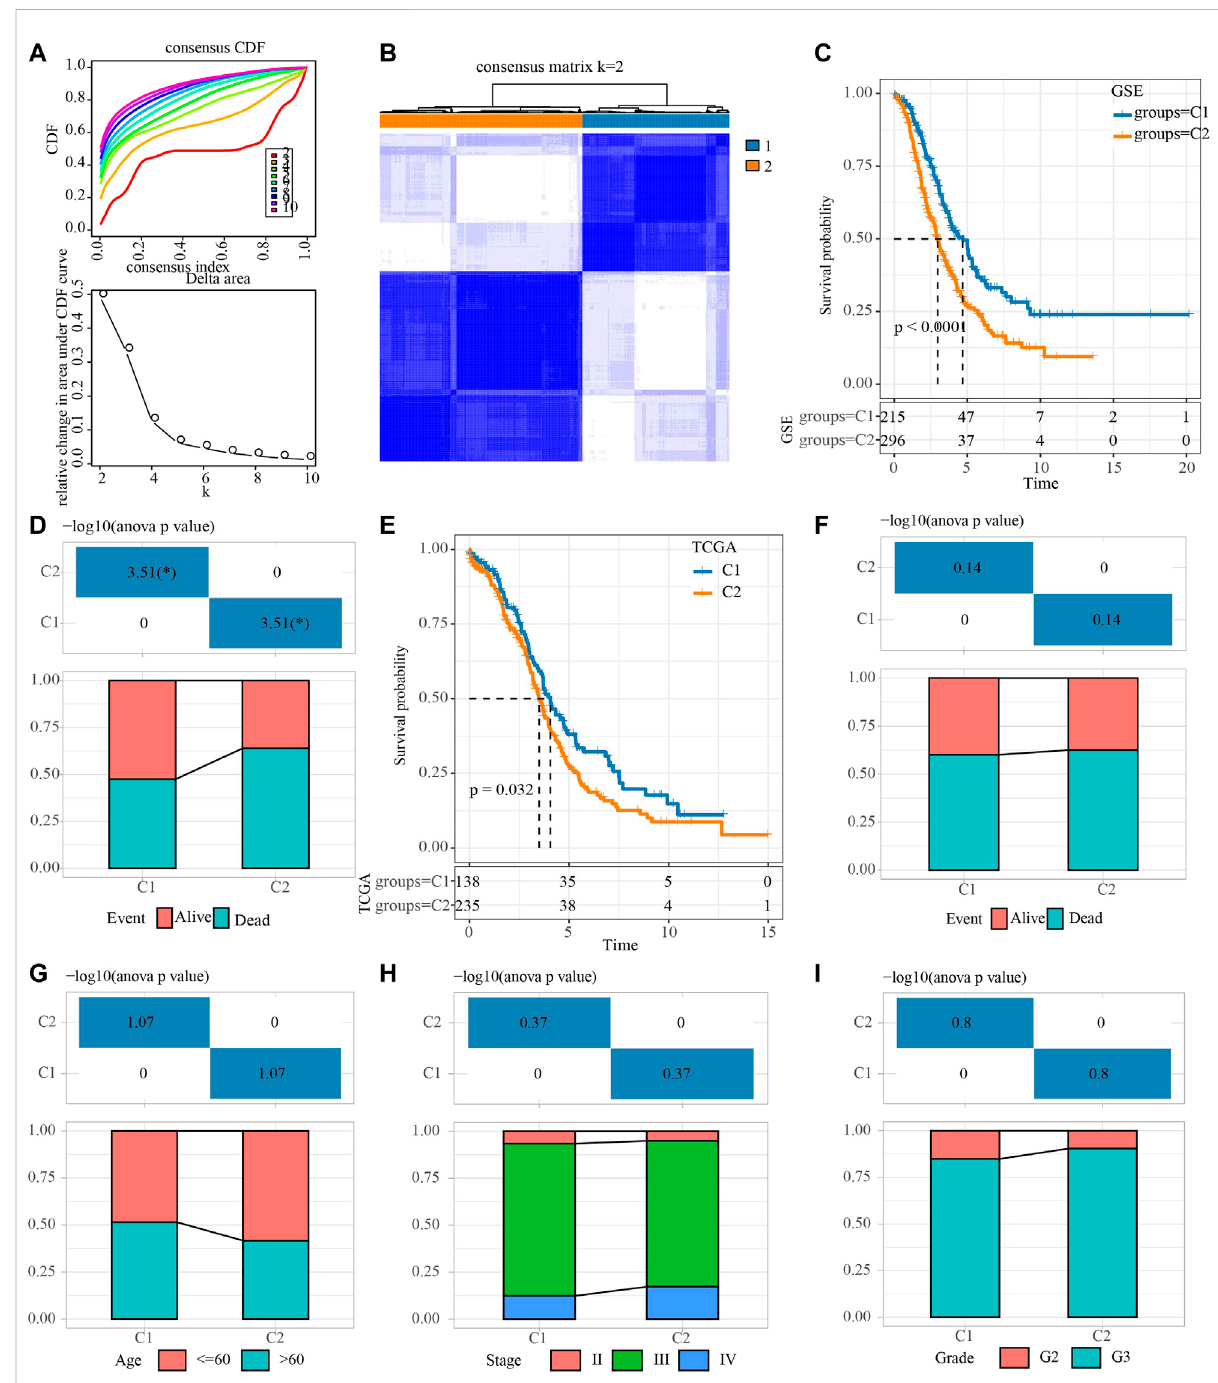
FIGURE 1 Identi fi cation of necroptosis subtypes for OV. (A) Consensus clustering heatmap for two subgroups. (B) CDF curve and the delta area of the clustering result. (C) Kaplan-Meier curve for LUAD patients in GSE dataset that merged four OV cohorts. (D) The distribution proportion of samples with different survival states in the two necroptosis subtypes of the GSE dataset that merged four OV cohorts. (E) Survival curve for LUAD patients in TCGA dataset. (F) Analysis of different survival states of two necroptosis subtypes in TCGA dataset. (G – I) : The characteristics of age, stage and grade of two necroptosis subtypes in TCGA